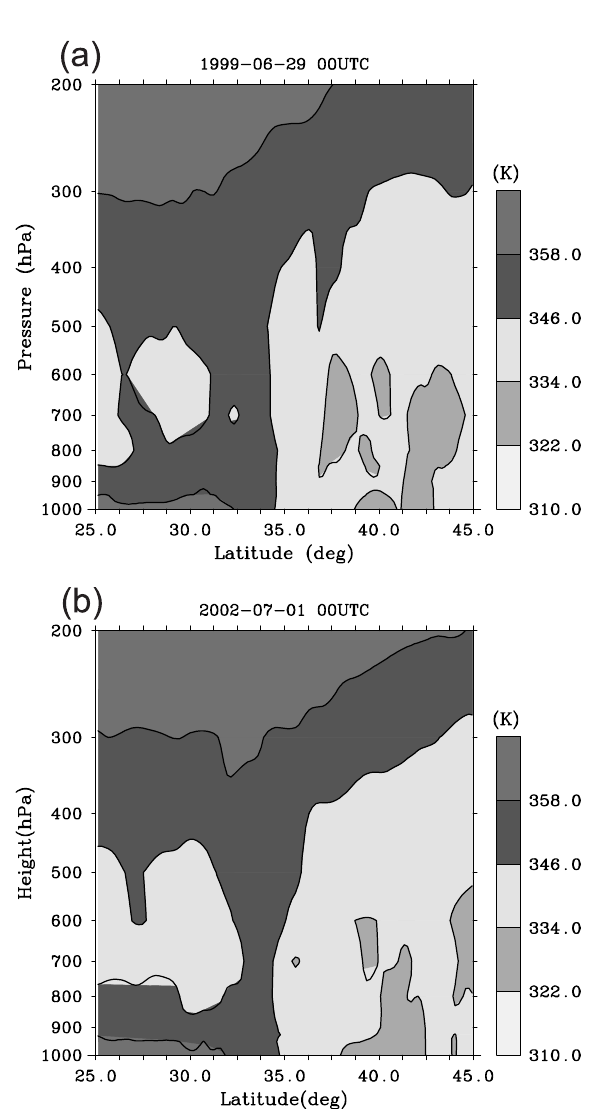
Fig. 5. North-south vertical cross sections of equivalent potential temperature along 130 ◦